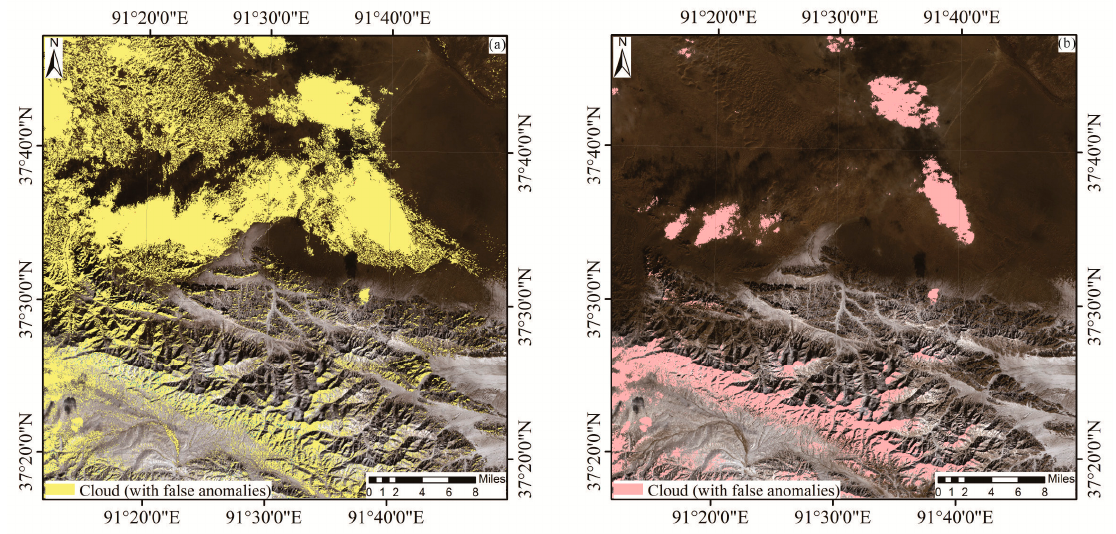
Figure 5. Cloud detection based on the DN-N fractal model. ( a ) Results of the DN-N fractal model for ROI 1, ( b ) results of the DN-N fractal model for ROI 2.